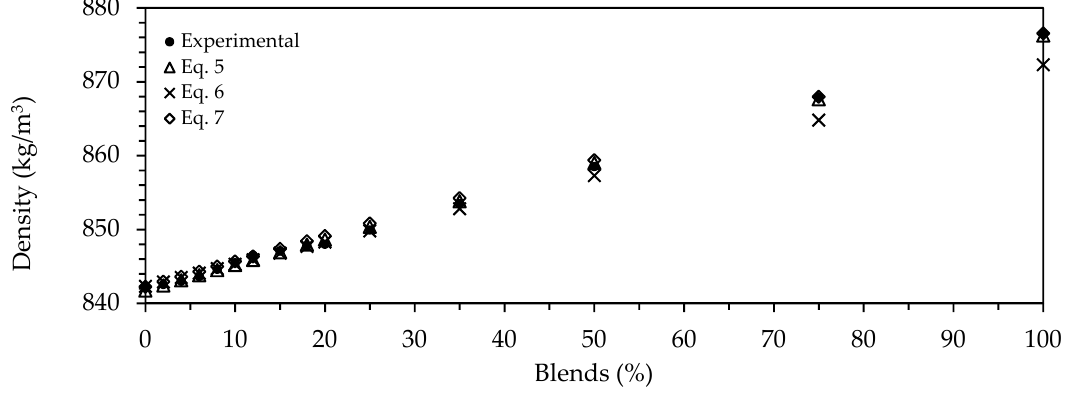
Figure 1. Density variation with biodiesel content.